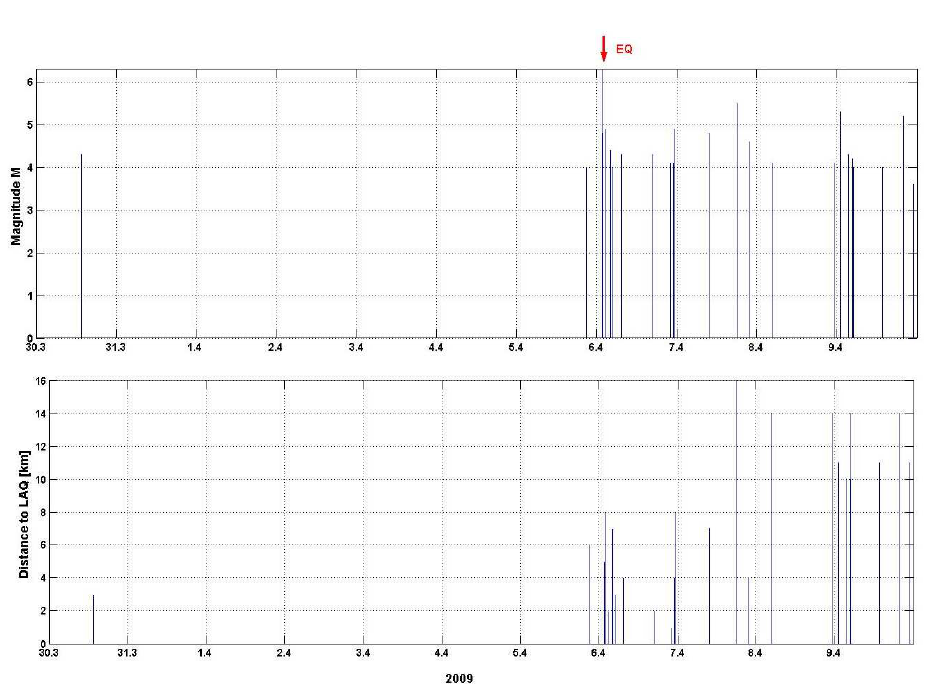
Figure 2 Fig. 2. Magnitude of seismic events (top panel) and distance to L’Aquila observatory during 30 March 2009 and 9 April 2009. The occurrence of the main stroke is indicated with an arrow. The magnitude of the seismic events is shown in the upper panel, the distances of earthquakes epicenters to L’Aquila in the lower